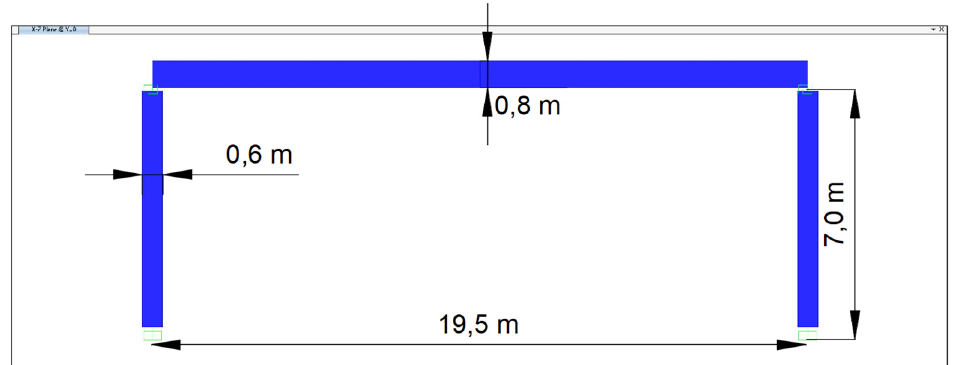
Figure 7. Portal frame model.